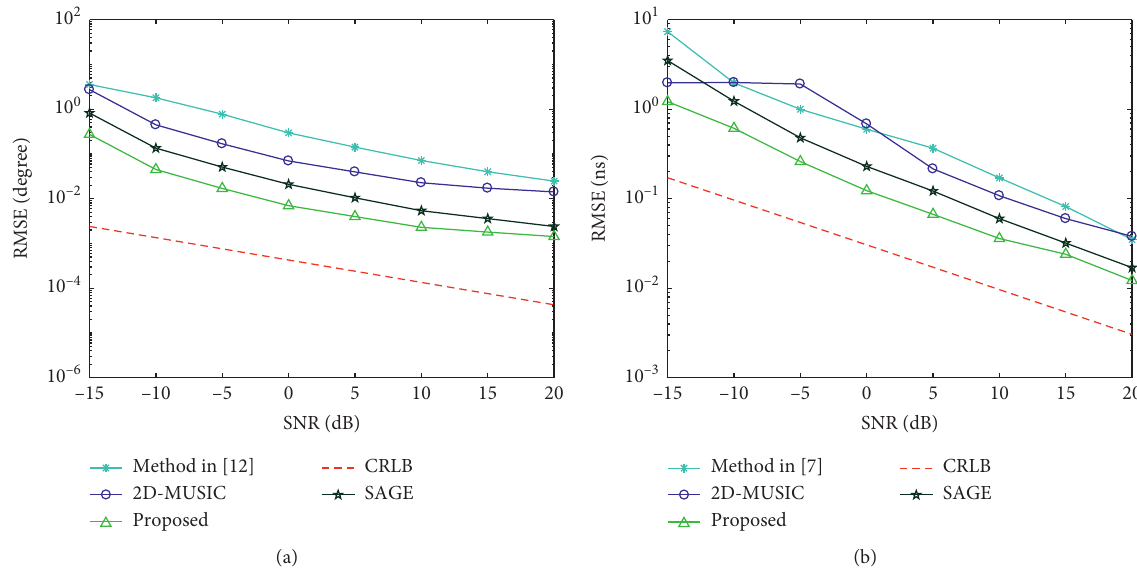
Figure 4: Performance comparison regarding SNR when signals are coherent. (a) DOA and (b) time delay.